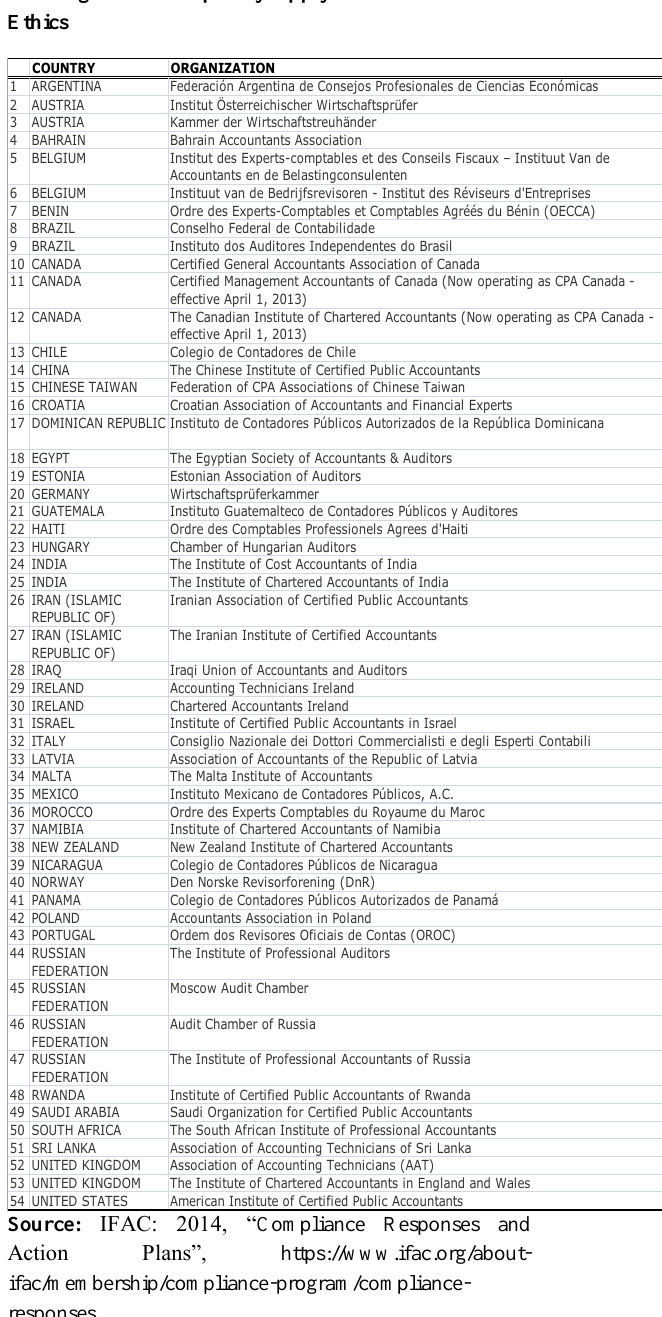
Table 3: Accounting Organizations that Plan to Converge to or Completely Apply the IFAC Code